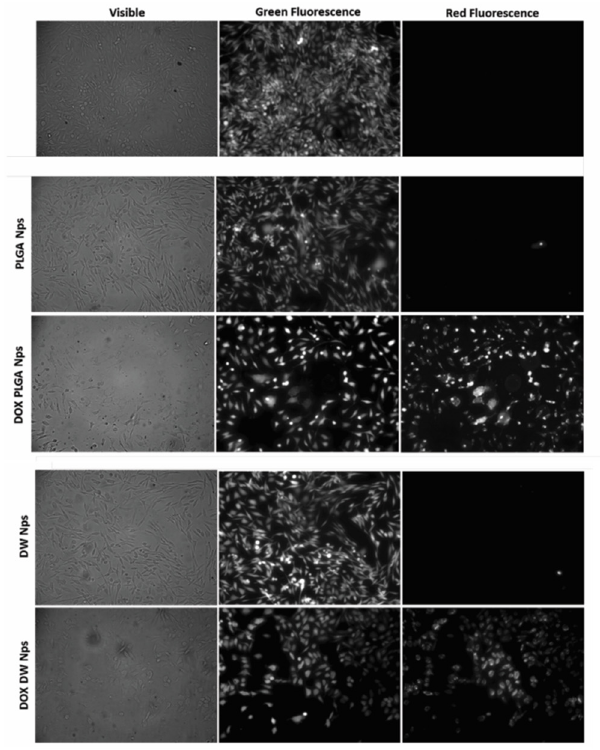
Figure 8. Fluorescence microscopy photographs of CHO cells post-LIVE/DEAD viability/cytotoxicity assay obtained with no addition of NP (negative control) and with the addition of empty and doxorubicin-loaded PLGA NP and DWNPs 6:1. Viable cells fluoresce green while doxorubicin fluoresces red.